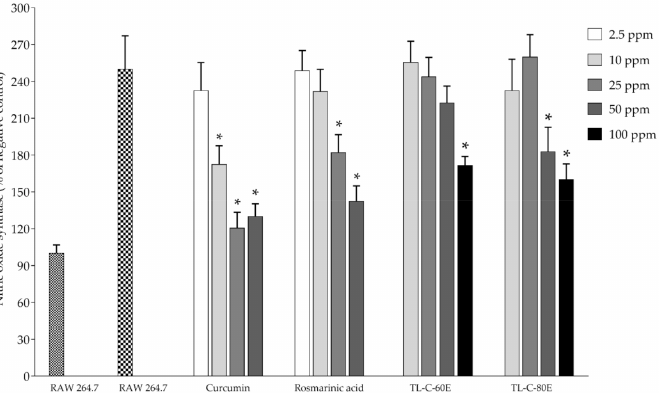
Figure 4. Inhibition effect of SRAEE on inducible nitric oxide synthase production. Data represents the mean ± SD of three independent experiments. * Indicate a significant difference of experimental samples versus treated cells with combined LPS and IFN- γ induction ( p <